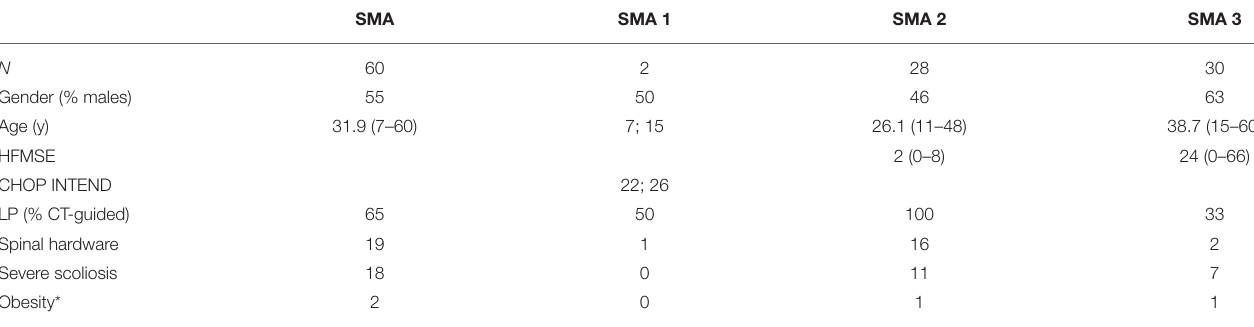
TABLE 1 | Summary of demographic patient